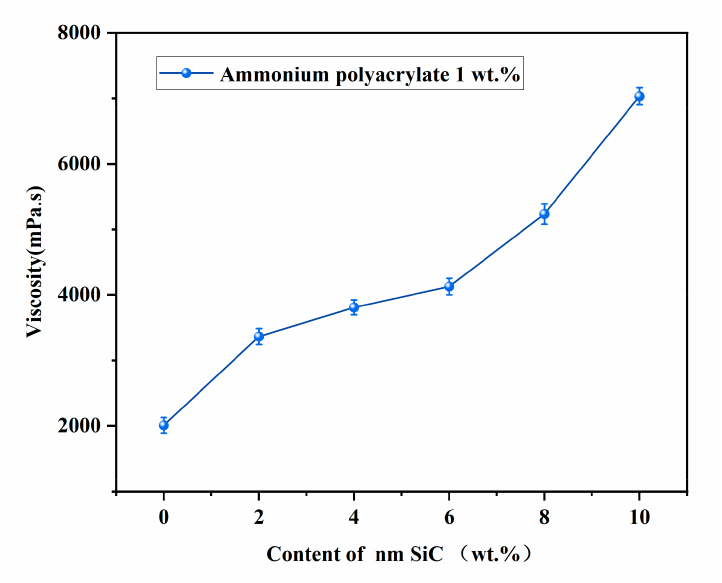
Figure 5. The viscosity of the slurry at different SiC nanoparticle